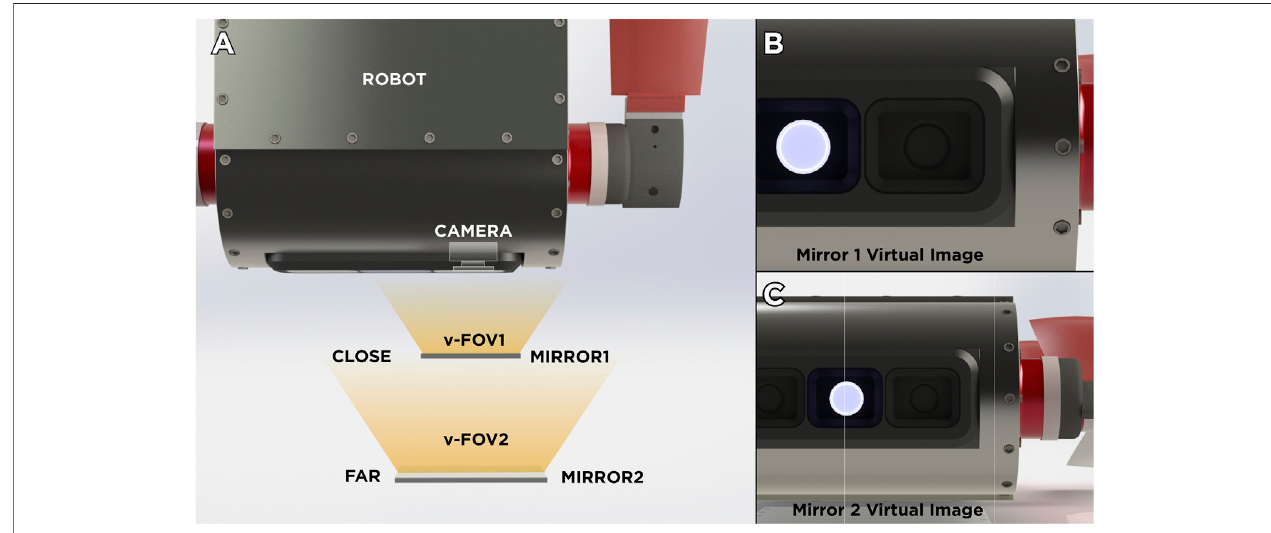
FIGURE 1 | Illustrative comparison of virtual images produced by the mirror position. (A) General Overview of two scenarios. (B) Virtual Image produced when mirror is placed near from the robot ’ s camera. (C) Virtual Image produced when mirror is placed near from the robot ’ s camera.